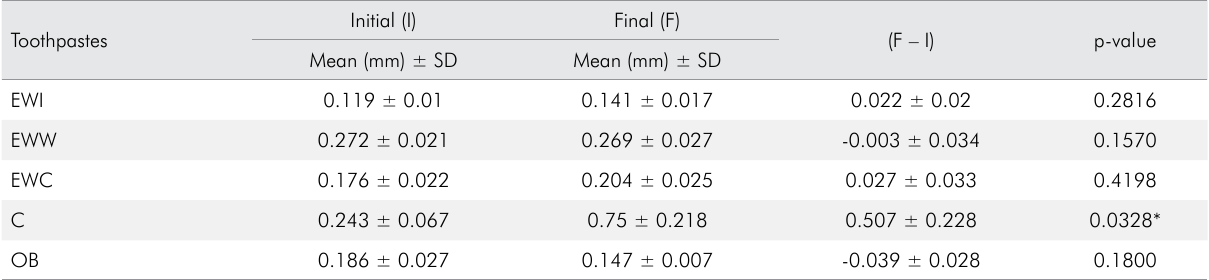
Table 2. Mean values of enamel surface roughness (µm) and standard deviations from the initial to final values.